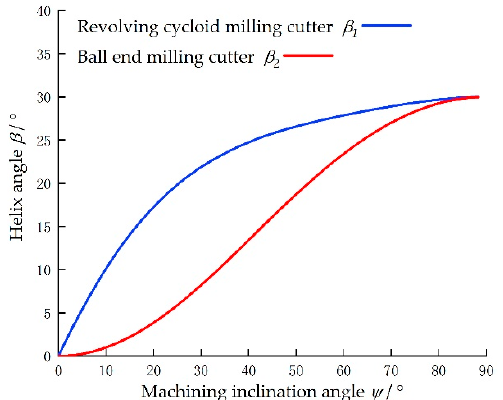
ff erent machining inclination